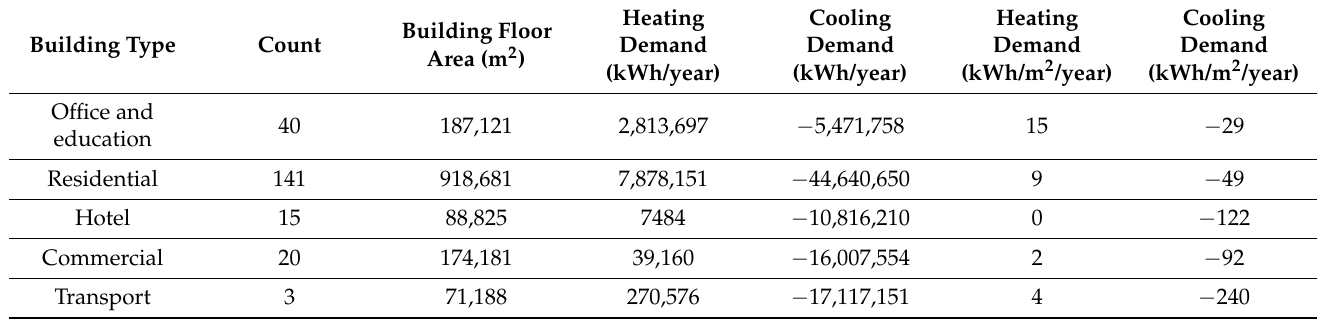
Table 6. Output of annual heating and cooling demands, based on five building functions.